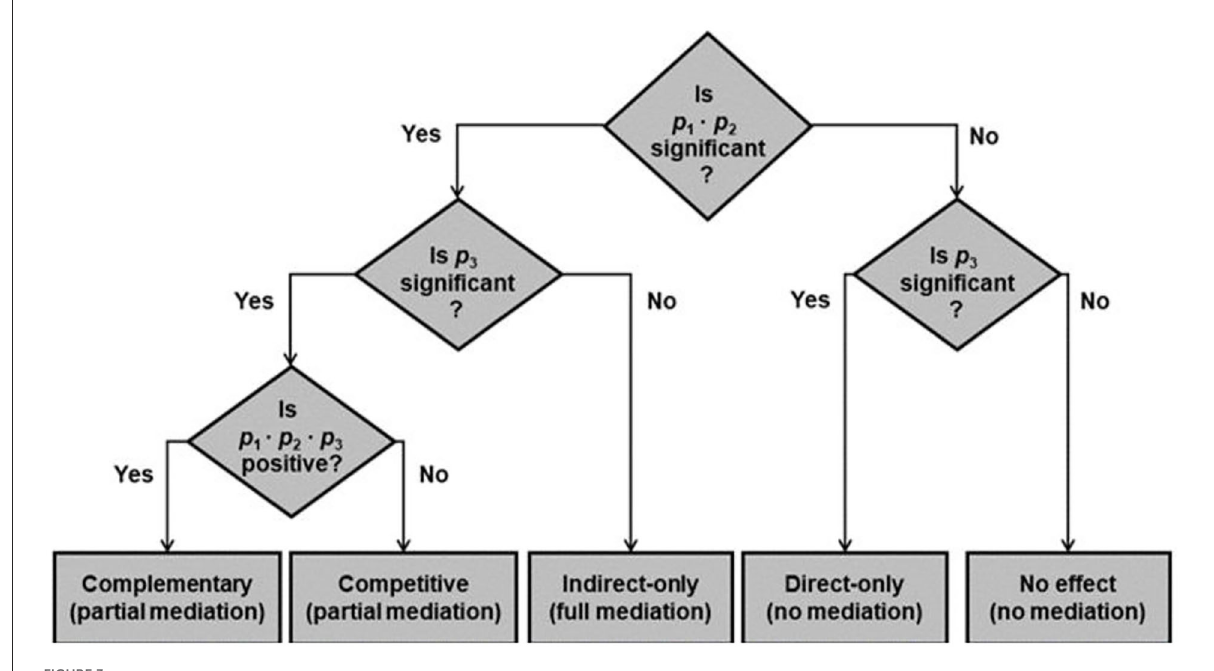
FIGURE3 Decision tree of analyzing the mediation effect (Zhao et al., 2010).